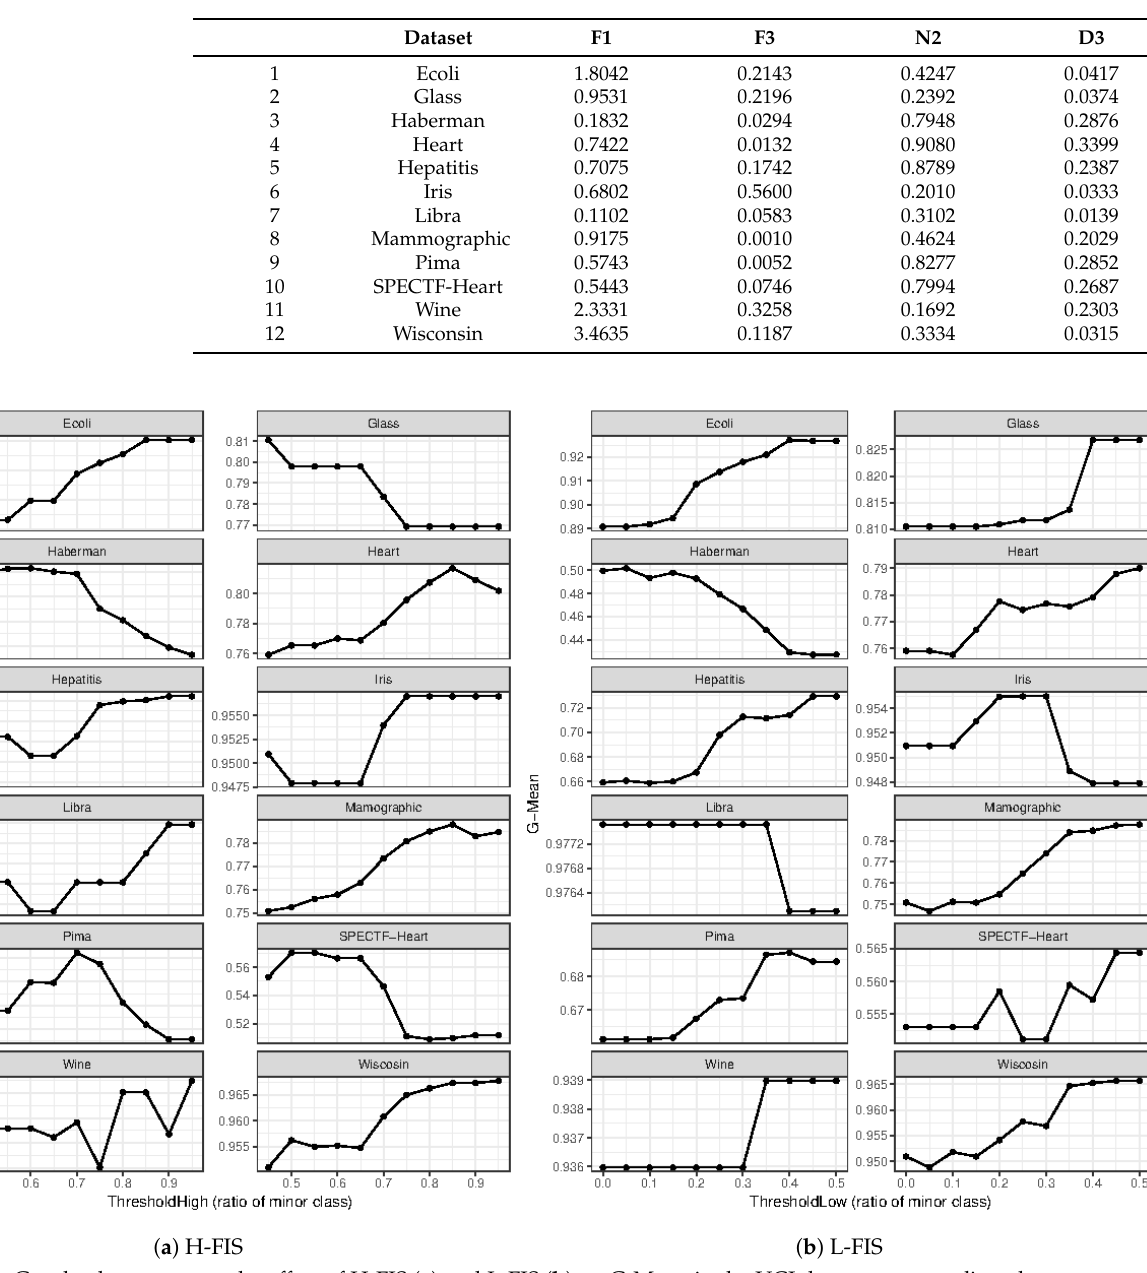
Table 9. Data complexity measures for the real datasets.